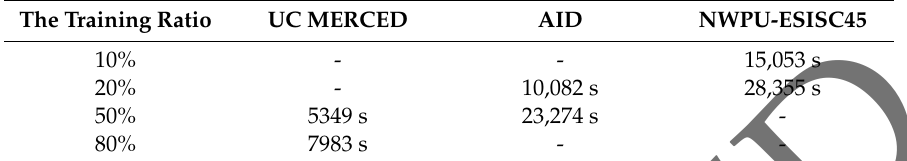
Table 5. The computation cost of the ADFF approach in three datasets.